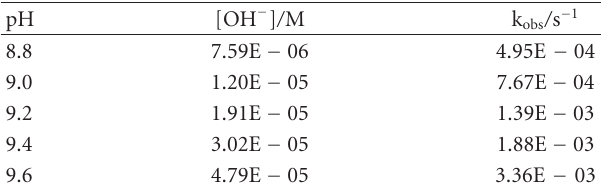
Table 3: Kinetic data for hydrolysis of [Pd(DEEN)(cysteine methyl ester)] 2+ at 25 ◦ C and 0.1 M ionic strength.